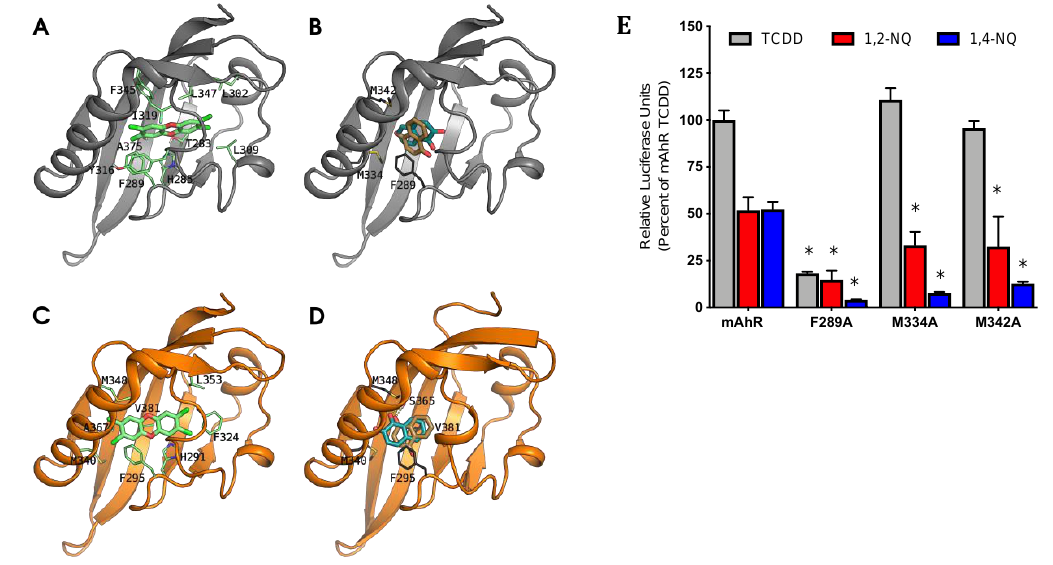
Figure 6. NQ interact with specific residues within the AhR binding cavity that are required for AhR functional activity. The models are shown as cartoons (mAhR in gray, hAhR in orange), and TCDD and NQs as sticks. The residues that mainly contribute to ∆ G bind are also shown as sticks (green for TCDD and dark gray for NQs). ( A ) TCDD pose in the mAhR LBD, taken as reference from previous analyses [44–46]: ( B ) NQs bind di ff erently in the mAhR LBD compared to TCDD: the main interactions are with M334, M342, and F289. ( C ) TCDD pose in the hAhR: due to the steric hindrance of V381 both the position and the laying plane of the molecule within the cavity are di ff erent compared to the pose in mAhR. ( D ) The NQs poses in the hAhR are in the same relative position in the binding site as in the mAhR LBD, but additional stabilization provided by ligand interactions with V381 and S365 result in di ff erences in NQ orientations. ( E ) COS-1 cells transiently transfected with wild-type or mutant mAhR pGudLuc6.1 were incubated with DMSO (0.1%, v / v ), TCDD (10 nM), 1,2-NQ (5 µ M), or 1,4-NQ (5 µ M) for 18 to 22 h. Luciferase activity was measured, corrected for background activity (DMSO), and normalized to TCDD activity induced in mAhR transfected cells. Values represent the mean ± standard deviation of three independent experiments. Asterisks (*) indicate those values that are significantly reduced relative to that of mAhR at p < 0.05 as determined by Two-Way